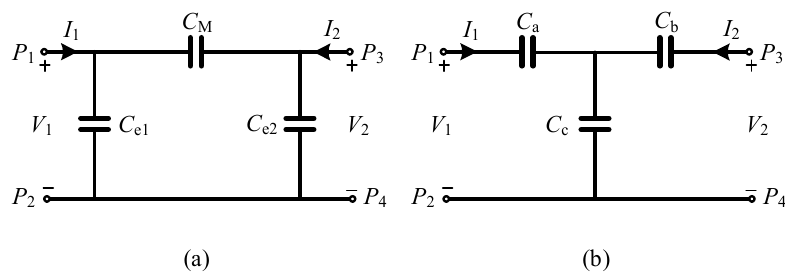
Figure 4. Simplified coupler structure. ( a ) π -type model. ( b ) T-type model.